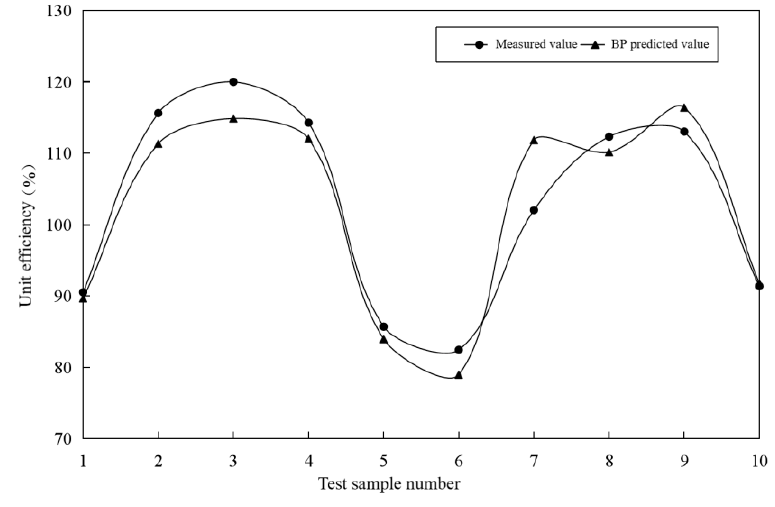
Figure 8. The predicted value of BP ANN on the unit efficiency.